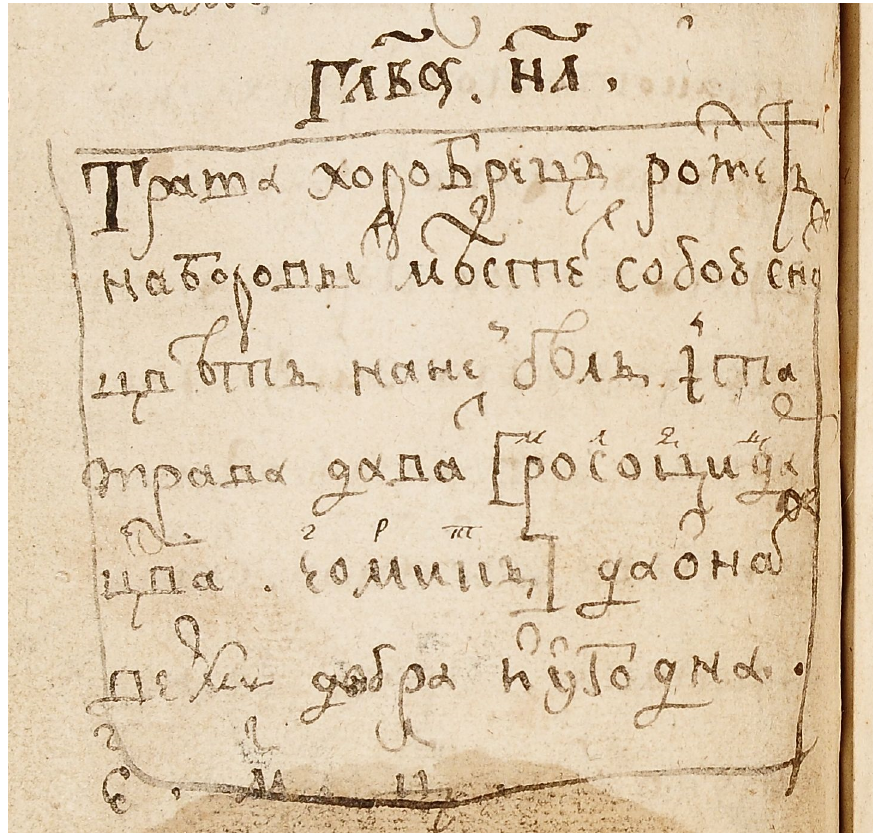
Figure 2. Text about Khorobrets plant with cryptogram, 1703 (RGB. Undolsky coll. No. 1072. Fol. 28v. No.